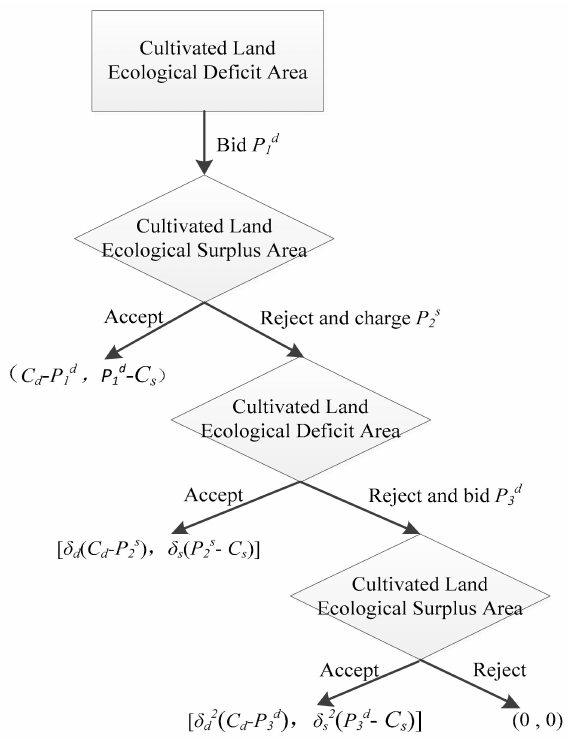
Figure 1. Three-stage bargaining game tree of ecological compensation for cultivated